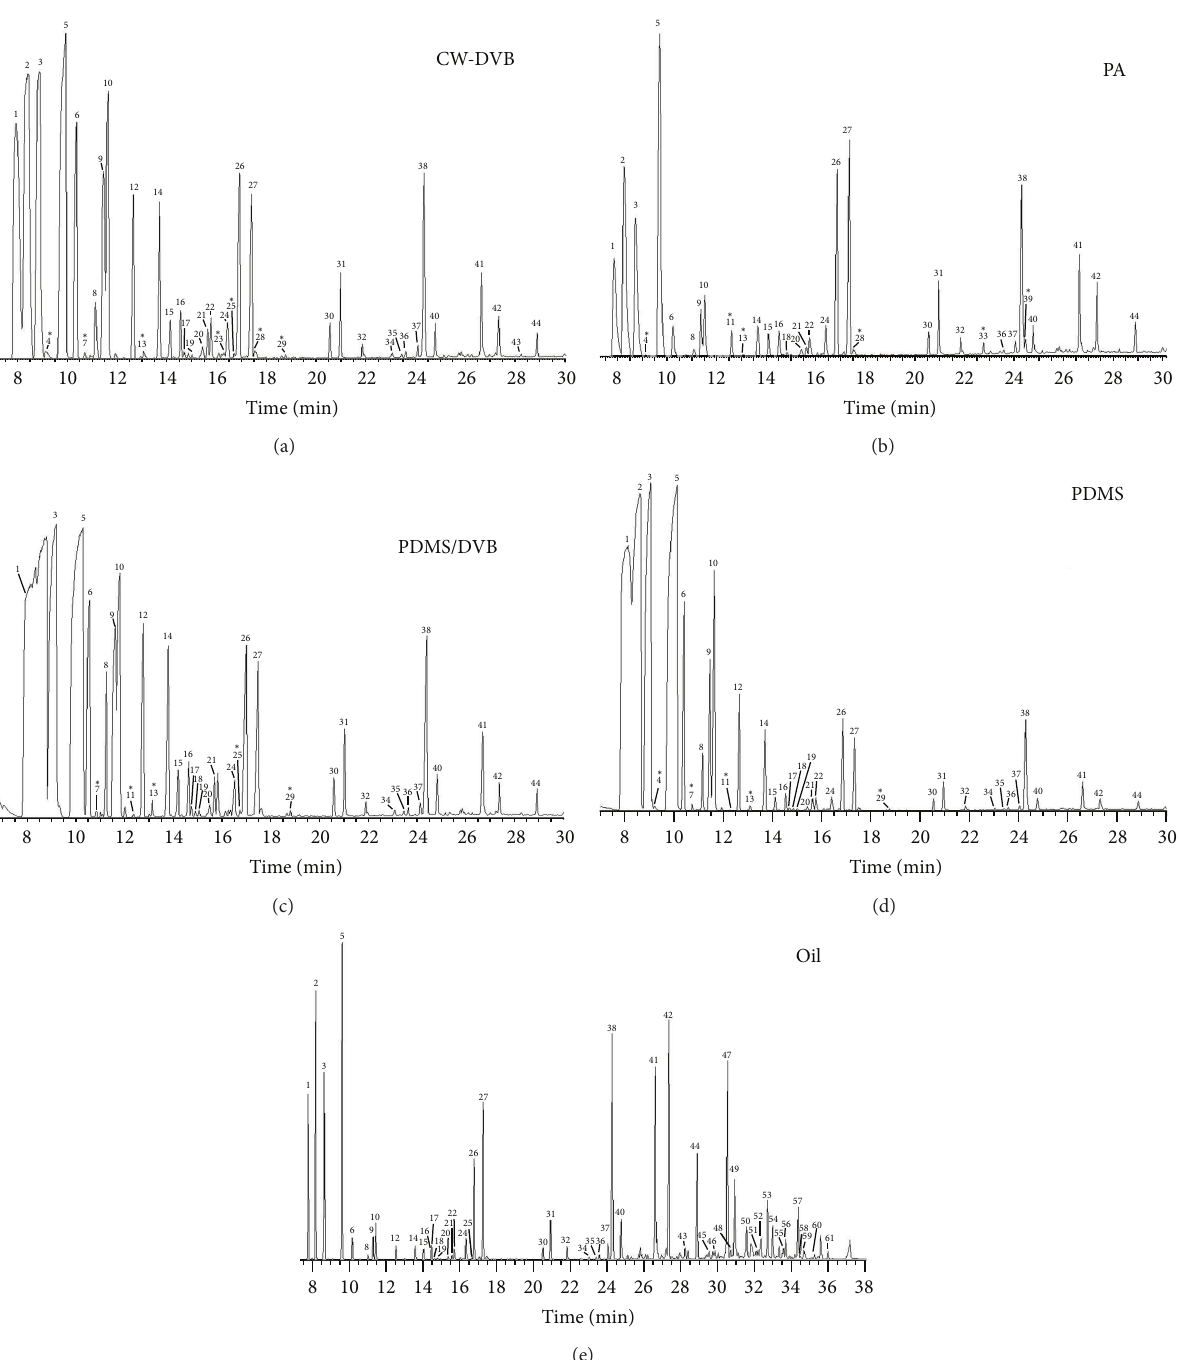
and ketones represent an important fraction of the chemical 1-en-8-ol (5.24%), 8S- cis -5(1H)-azulenone, and 2.4.6.7.8.8a- hexahydro-3.8-dimethyl-4-(1-methylethylidene) (3.33%) the major components with these functional